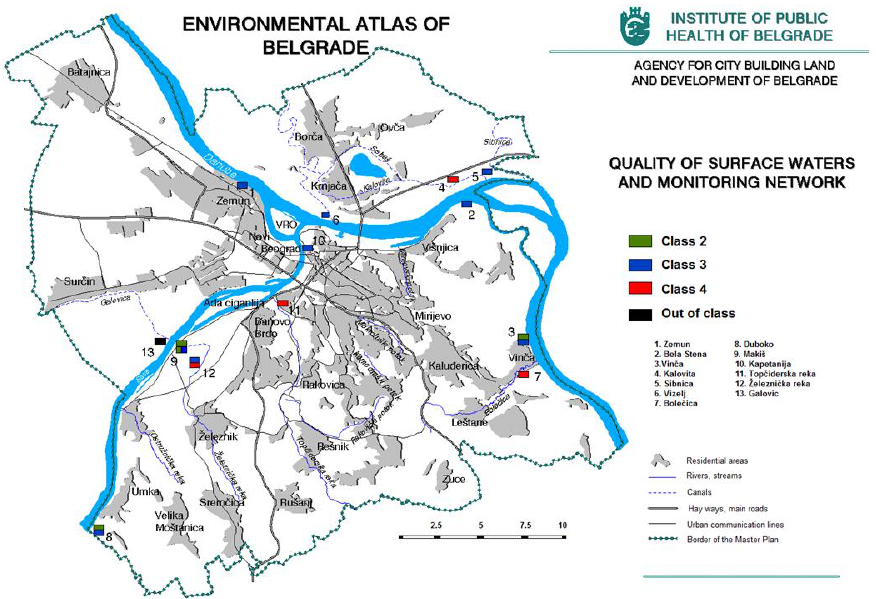
Figure 5. The air quality of Belgrade (https://www.zdravlje.org.rs/ekoatlas/volbe/36ev.gif, accessed on 23 August 2022).